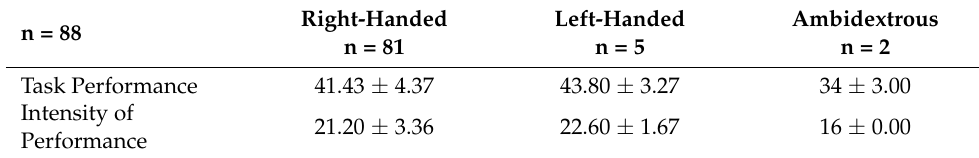
Table 4. Task and intensity performance average results by hand